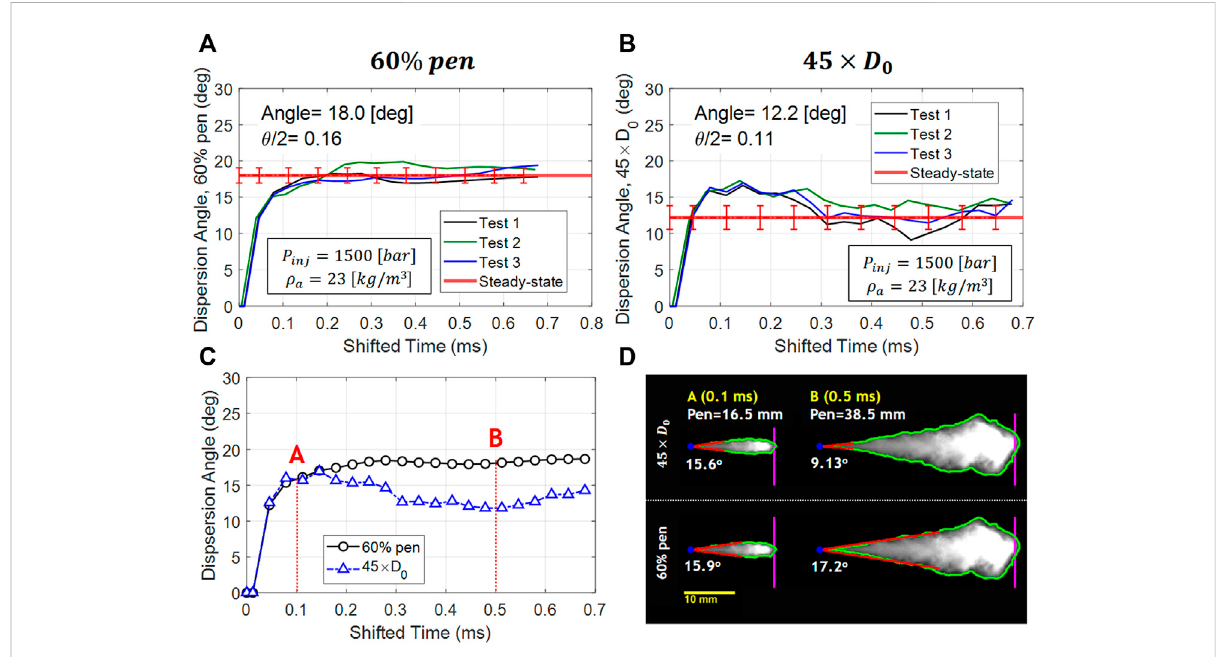
FIGURE 7 Dispersion angle of the single-hole injector from different de fi nitions: (A) 60% of maximum penetration (60% pen) and (B) 45 times the ori fi ce diameter (45× D 0 ), with averaged dispersion angle at a steady state with measurement uncertainty. (C) Transient averaged dispersion angles from two separate de fi nitions at points A and B (D) Instantaneous snapshots of the 2D side view from the selected time instances marked in (C) .